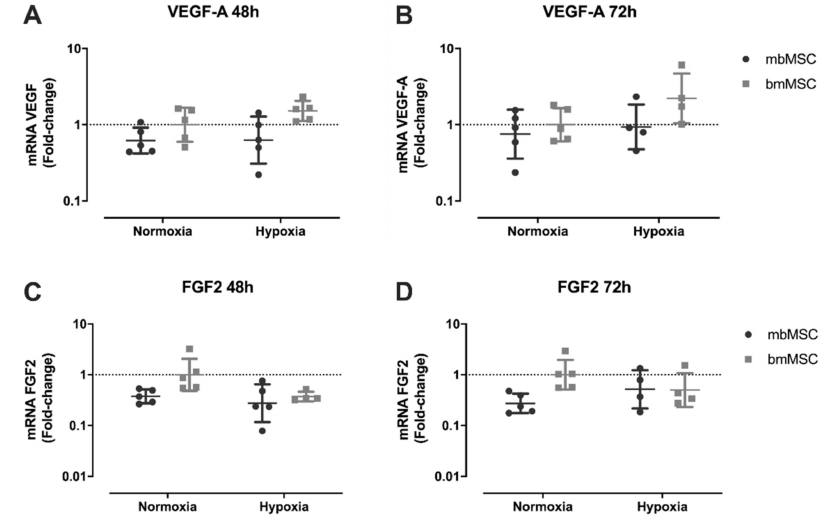
Figure 6. Expression of angiogenic growth factors VEGF-A and FGF2 after 48 and 72 h of culture in a serum-free condition by real time RT-PCR. ( A – D ) Comparison of mbMSC and bmMSC expression with each other, at di ff erent O 2 concentrations. ( A , B ) VEGF-A expression in MSC cultured for 48 and 72 h, respectively. ( C , D ) FGF2 expression in MSC cultured for 48 and 72 h, respectively. For VEGF-A and FGF2 comparison, bmMSC in normoxia was used as a control group. Nor, normoxia; Hyp, hypoxia. RT-PCR, reverse transcription-polymerase chain reaction. VEGF-A, vascular endothelial growth factor A. FGF2, fibroblast growth factor